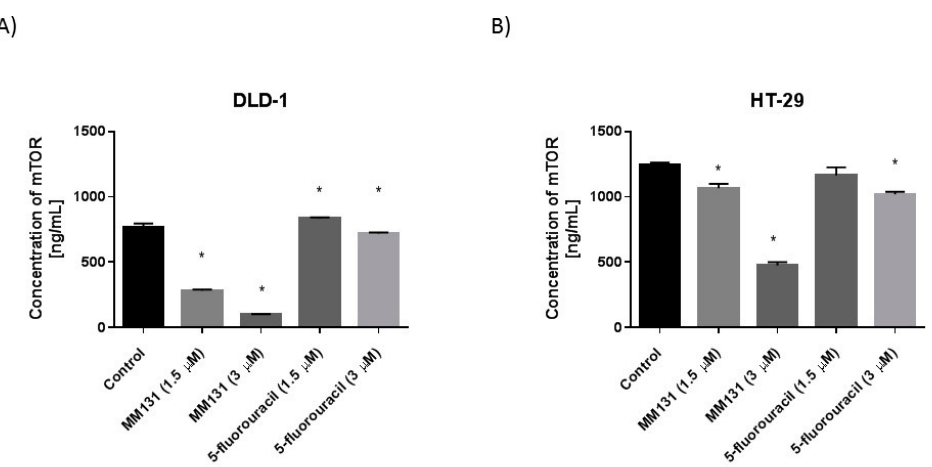
Figure 10. Quantification of mTOR by ELISA. Bar graphs demonstrating mTOR concentration in DLD-1 ( A ) and HT-29 ( B ) colorectal cancer cells after 24 h of incubation with MM131 and 5-fluorouracil. n = 3 in duplicates; * p < 0.05 versus respective control